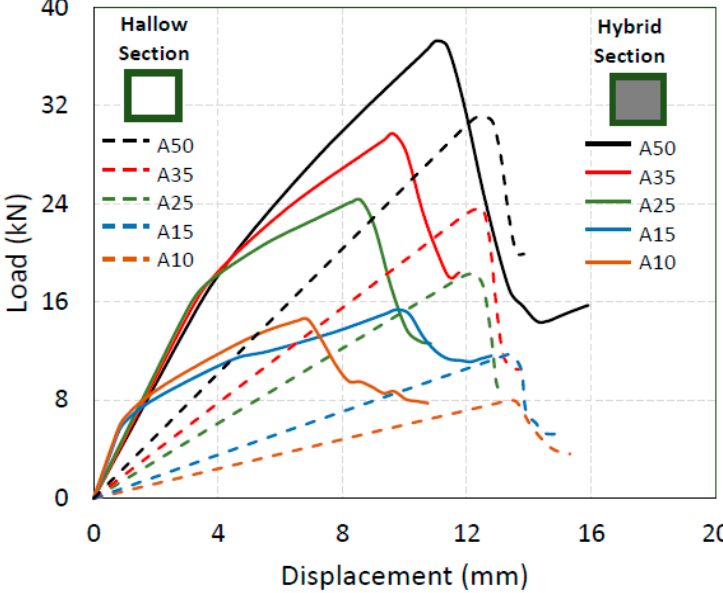
Figure 5. Load-deflection curves of areal change in square beams.